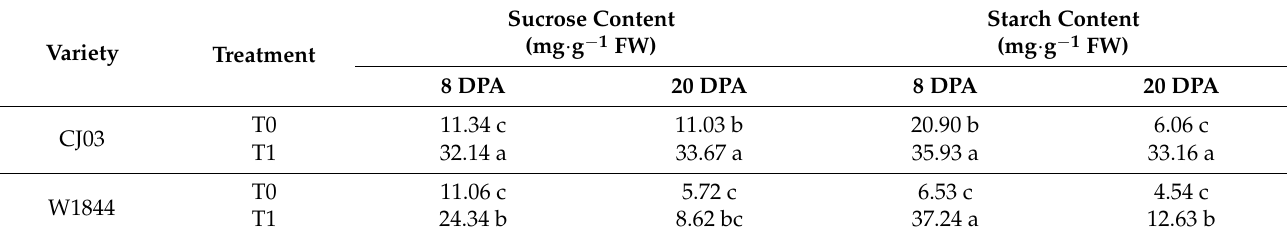
Table 4. Carbohydrate content of stem during grain filling in